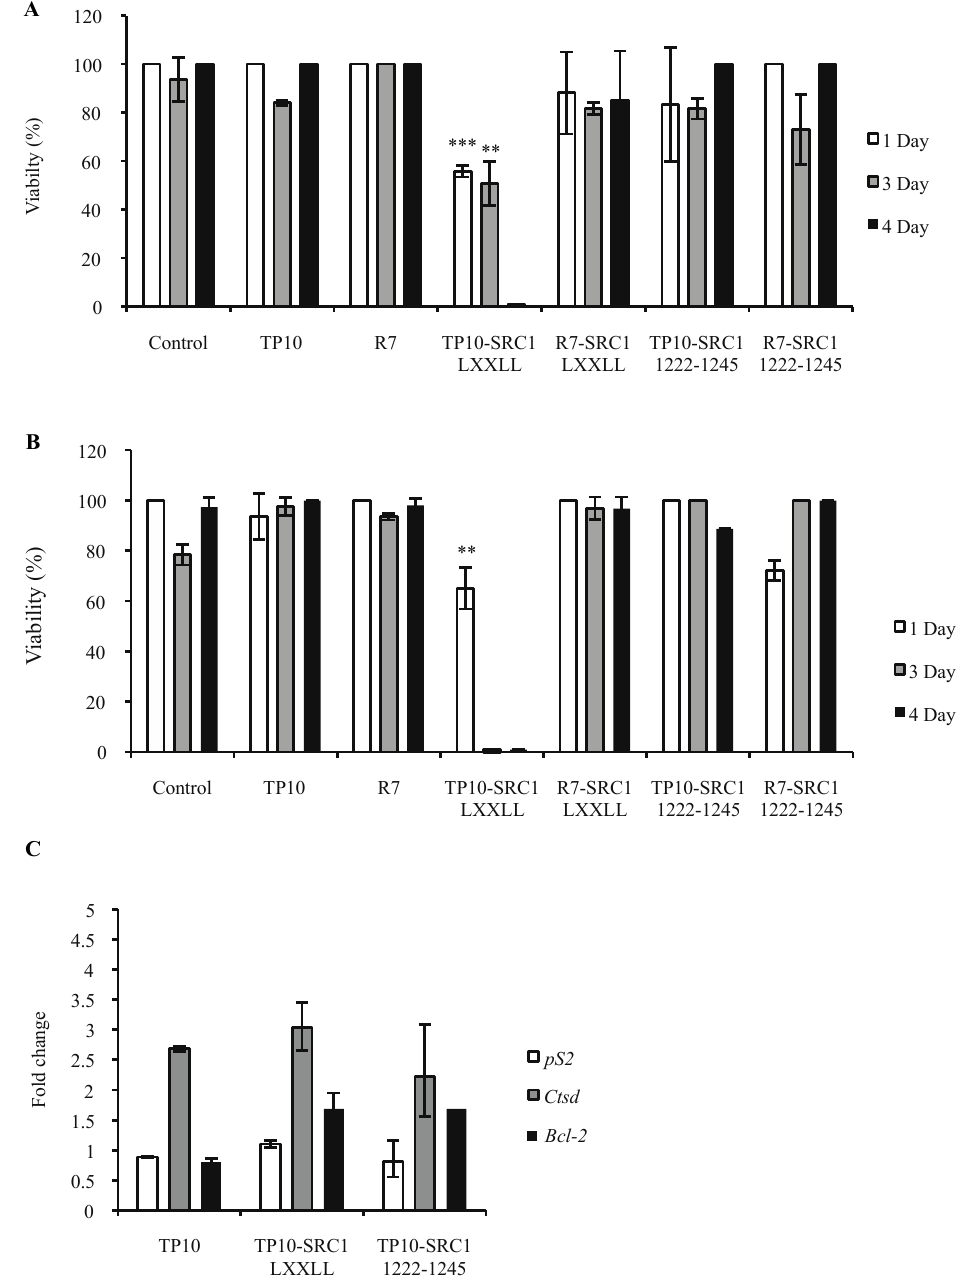
Figure 3. Inhibition of cell viability by SRC-1 bioportides and their influence on ER α -mediated gene transactivation. ( A ) MCF-7 cells; ( B ) MDA-MB-231 cells. Cells were seeded in 24-well plates at low density and were treated every 24 h for 4 days with 5 µM peptide. Cell proliferation was measured after 1, 3, and 4 days of peptide treatment via a propidium iodide viability assay. Differences were found to be statistically significant with ** p < 0.01, *** p < 0.001; ( C ) Endogenous ER α target genes pS2 , CTSD , and BCL2 mRNA expression analysis. MCF-7 cells were cultured with 5 µM of the indicated peptides and analyzed on day 2 of treatment. The fold change is the value compared with untreated cells. The values shown represent the mean values of one representative experiment, carried out in triplicate (mean ± SD). In total, three independent experiments were